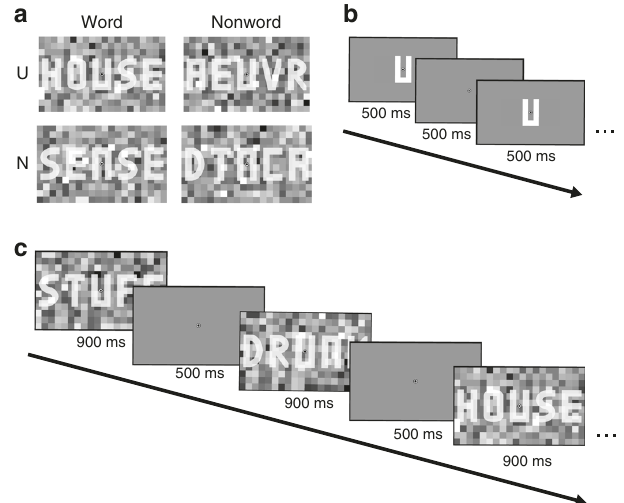
Fig. 1 Experimental paradigm. a Example stimuli for each condition. Participants observed words or nonwords (i.e. orthographically illegal, unpronounceable strings) with a U or N as middle letter, resulting in four conditions. b Functional localiser. During the functional localiser, the key letters (U and N) were presented in isolation and without visual noise, while participants performed an irrelevant task at fi xation. c Trial structure. We used a blocked design, in which each 14-s trial consisted of ten words or nonwords with a fi xed middle letter. Participants performed an orthographic discrimination task on speci fi c, prelearned targets that occurred once or occasionally twice per trial. Participants were trained in a separate session to perform the task while maintaining fi xation at the centre of the performed a spelling discrimination task on speci fi c target stimuli that occurred occasionally (1 – 2 times) per trial. Target stimuli were learned during a prior training session. Targets were pre- sented either in their regular form or with one letter permuted, incorrectly (i.e. presented in the learned form or permuted).